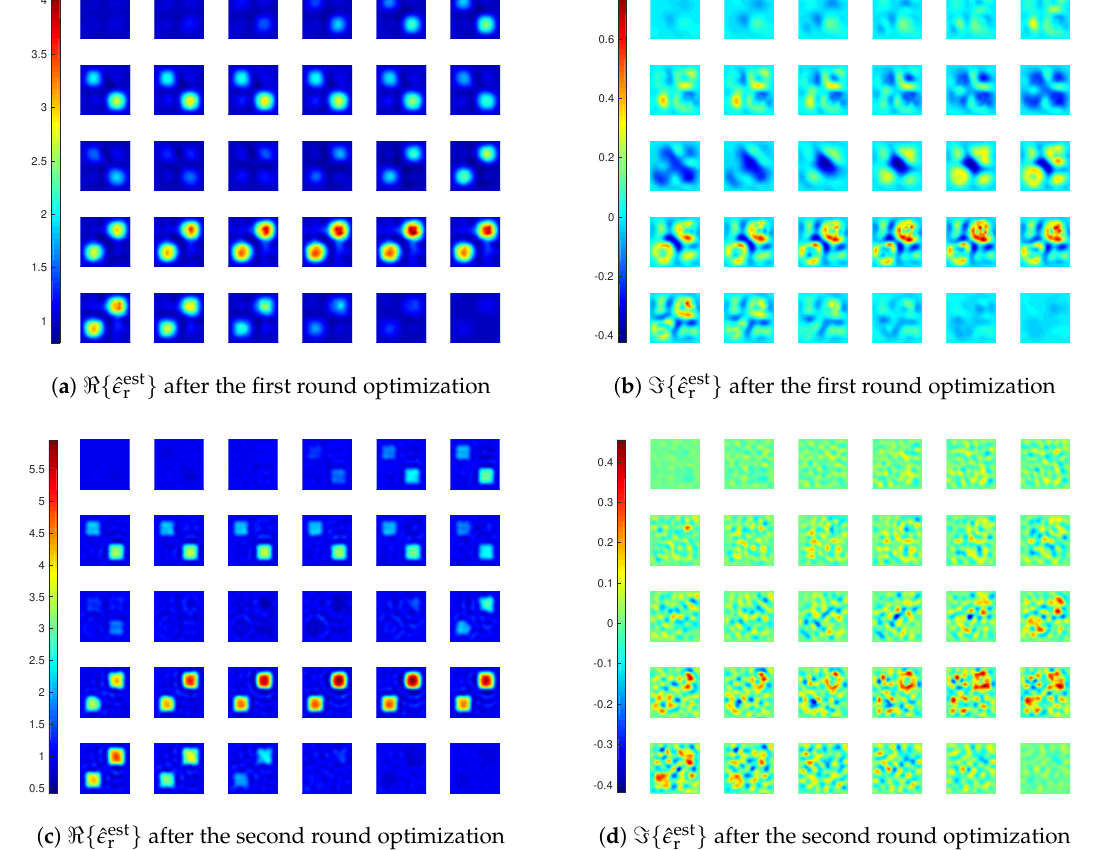
Figure 10. Reconstruction results of inversions with CIE-I for Example 2 . In the first round, β 1 = β 2 = 6. In the second round, β 1 = β 2 = 1.